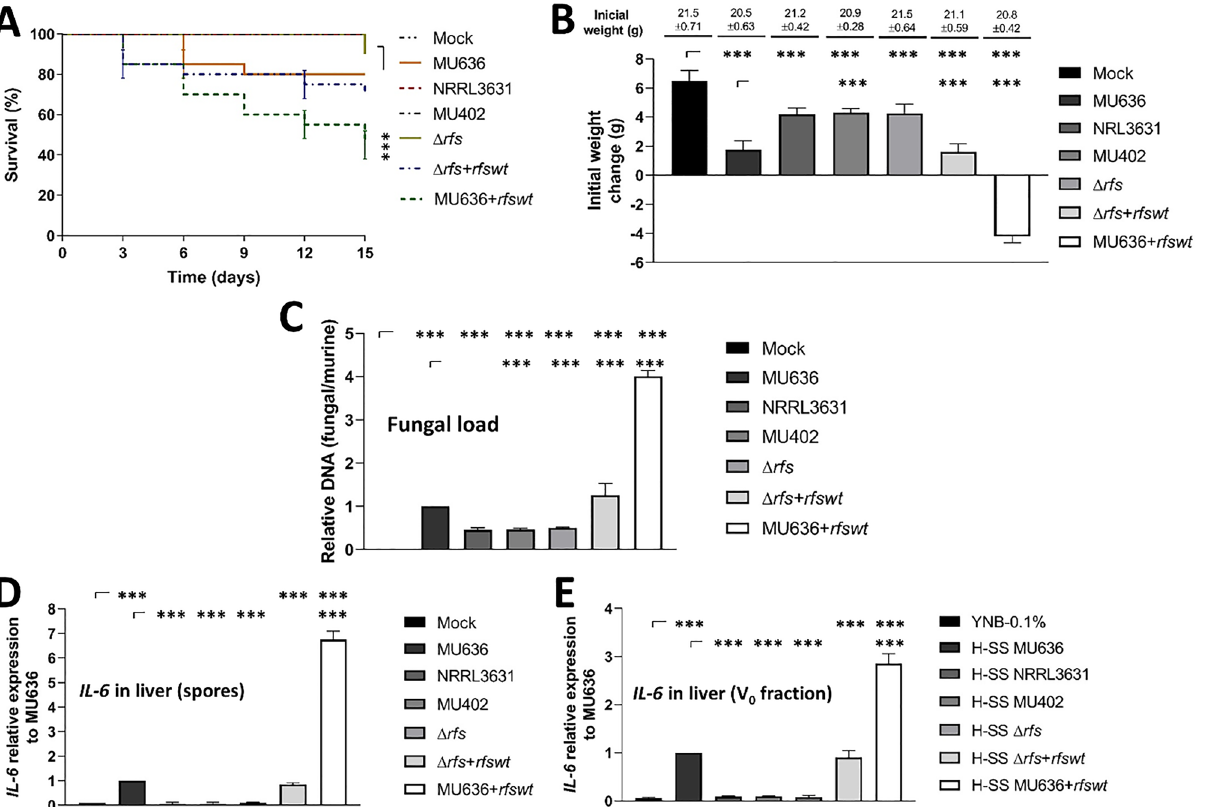
Figure 5. Role of rfs in the regulation of M. lusitanicus virulence in mice. ( A ) Spores (3 × 10 7 ) from the MU636, Δ rfs , Δ rfs + rfsw t, and MU636 + rfsw t strains were intraperitoneally injected into streptozotocin-induced diabetic mice, and survival was monitored daily for 15 days. The experiments were repeated two times in independent groups with n = 10. Data were statistically analyzed using the Mantel-Cox test. *** P < 0.01. When results were not considered significant, we did not provide an additional indication ( P > 0.05). Mice surviving after 7 days post-inoculation were considered to ( B ) determine the change in the weight of mice since the initial infection. Animals were euthanized at 15 days post-inoculation, and the livers were removed to isolate nucleic acids to determine the ( C ) fungal burden in the mice using quantitative polymerase chain reaction (qPCR) for the expression of the tfc-1 gene from M. lusitanicus and Actb from Mus musculus . A ΔCt analysis was performed to compare the relative abundance of the fungal DNA compared with that of the murine DNA. The mRNA levels of the inflammation marker IL-6 in the liver of mice ( D ) infected with spores from the different strains and ( E ) inoculated with 200 μL of the V o fraction obtained through a molecular weight exclusion filter (cut off 3 kDa) were measured using reverse transcription quantitative polymerase chain reaction (RT-qPCR). Data are presented as the average values obtained from four independent biological replicates; ± corresponds to standard error (SE). Significance testing was performed using ANOVA with Fisher’s exact test, * P < 0.05; ** P < 0.01; *** P <